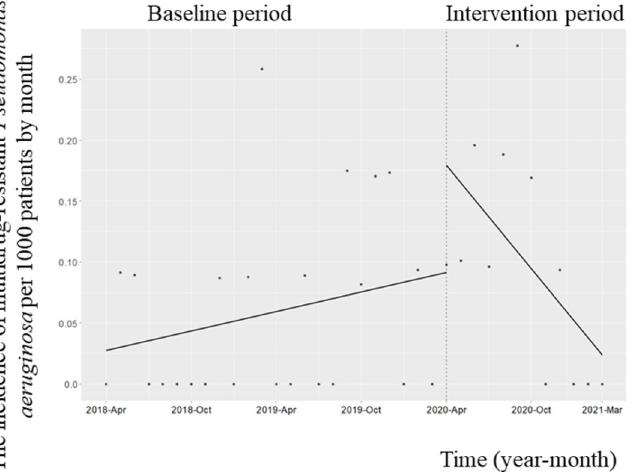
there was a significant reduction in the MRPA trend (coefficient: − 0.02; 95% CI: − 0.02 to − 0.004, p = 0.02); Fig 4). The level of the monthly incidence of MRSA did not decrease